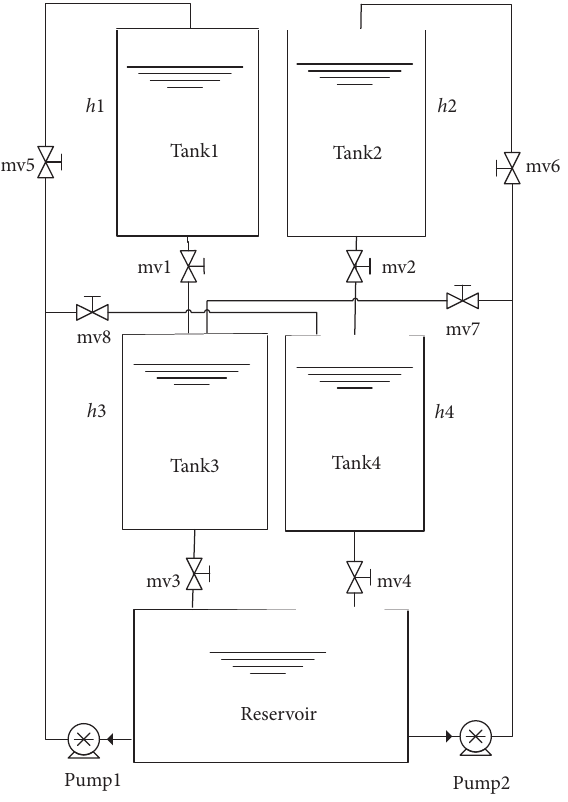
Figure 1: CFTLLS schematic